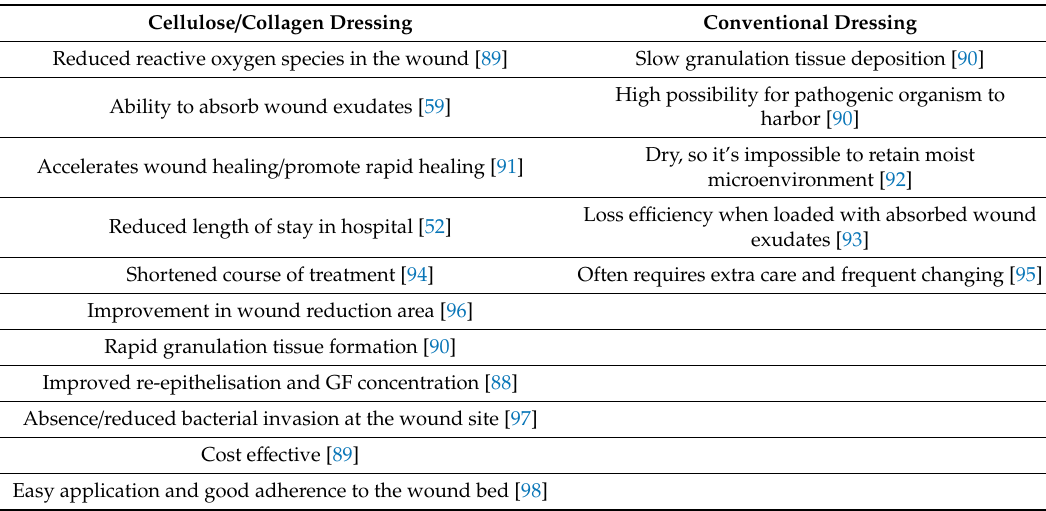
Table 2. Advantage of cellulose/collagen dressing.